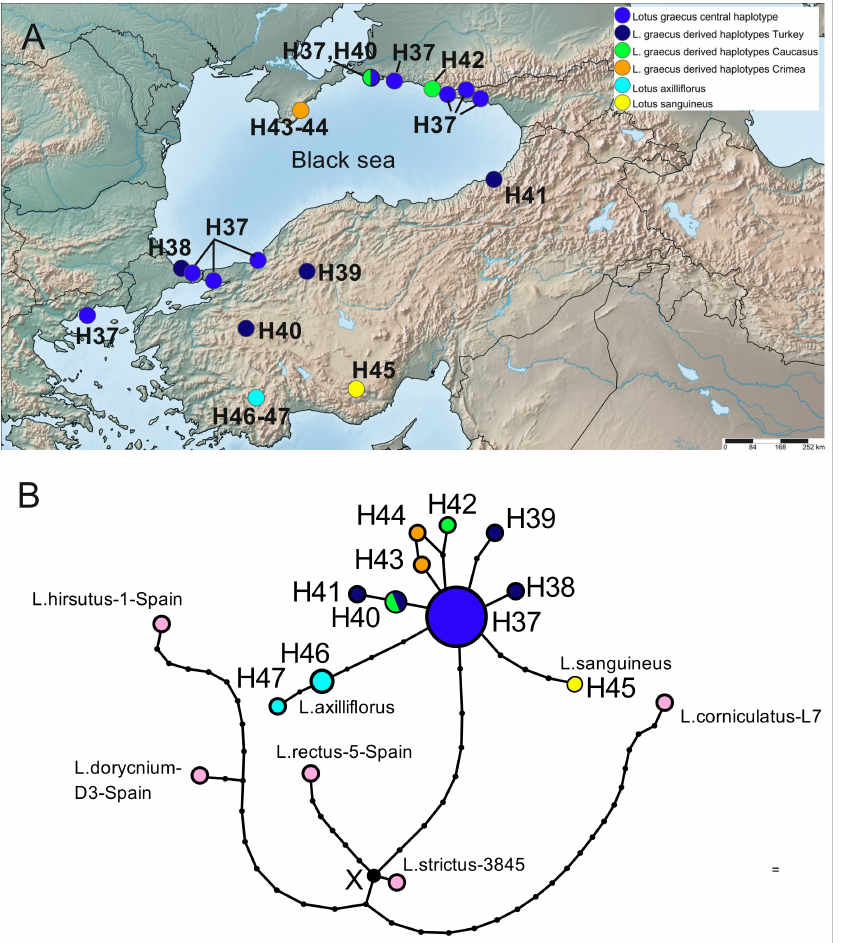
Figure 7. Geographical distribution of haplotypes identified in L. graecus , L. axilliflorus , and L. sanguineus ( A ) and haplotype network ( B ) reconstructed based on the combined plastid DNA dataset. The size of each circle is proportional to the frequency of the haplotype in the dataset. L. rectus , L. hirsutus , L. strictus , L. dorycnium , and L. corniculatus represent